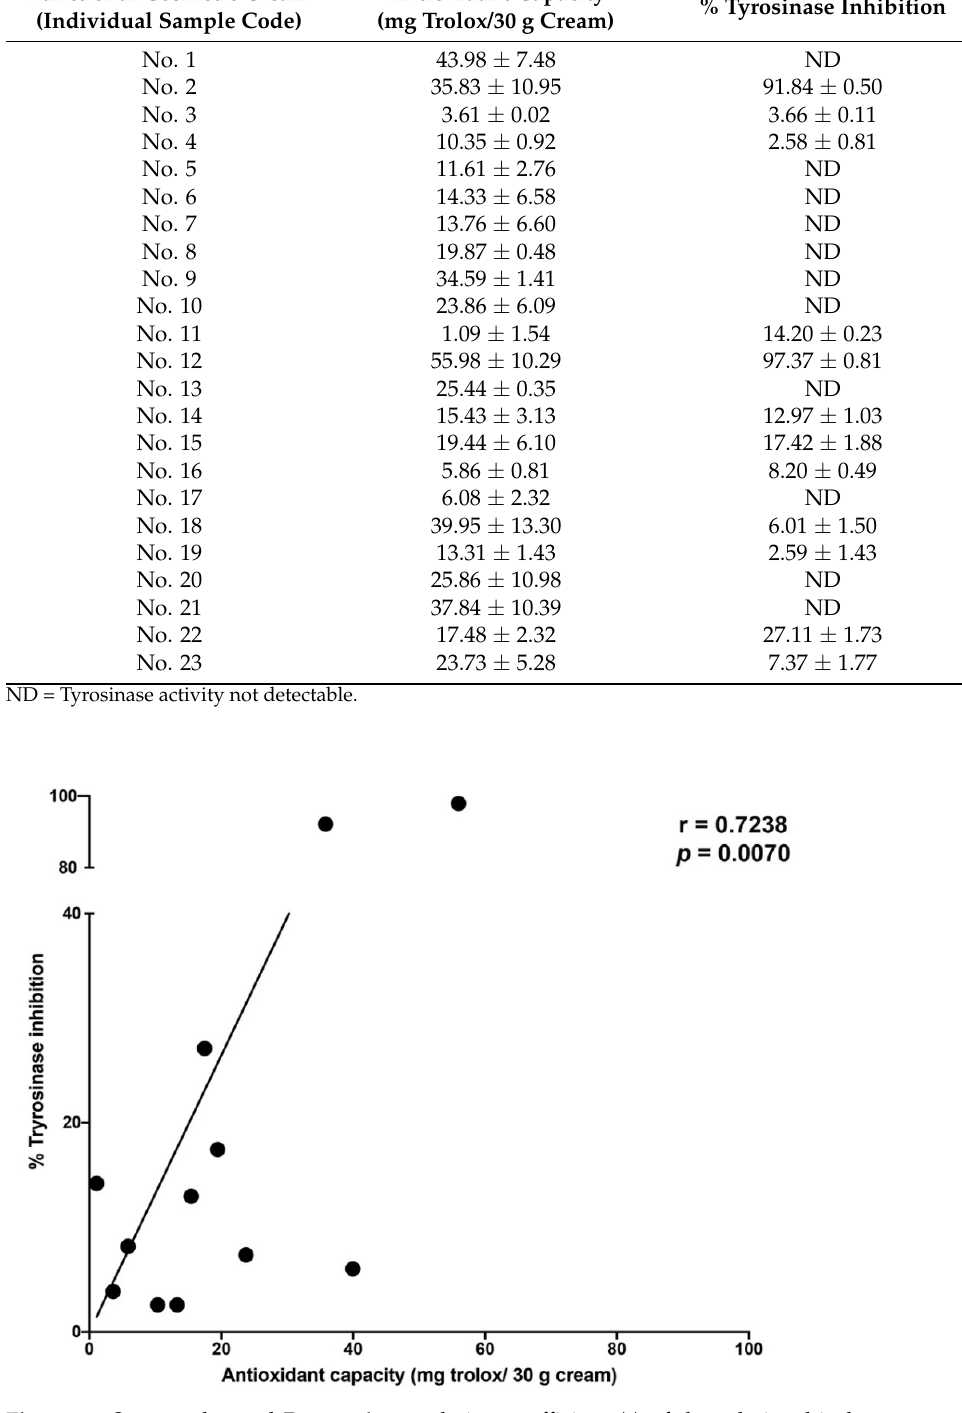
Figure 3. Scatter plot and Pearson’s correlation coefficient (r) of the relationship between total anti- oxidant capacity and % tyrosinase inhibition from 12 cream products available on the Thai